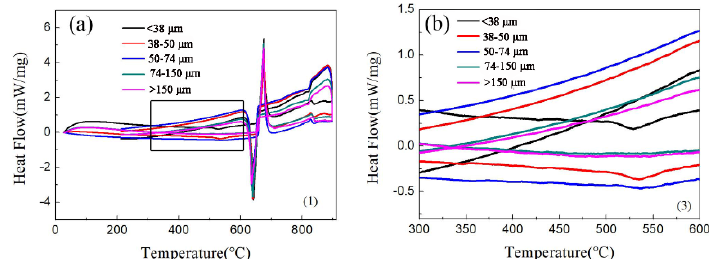
Figure 3. The DSC of aluminum alloy powder:( a ) full scan from 10 to 90 °C; ( b ) enlargement of the 300 to 600 °C section.